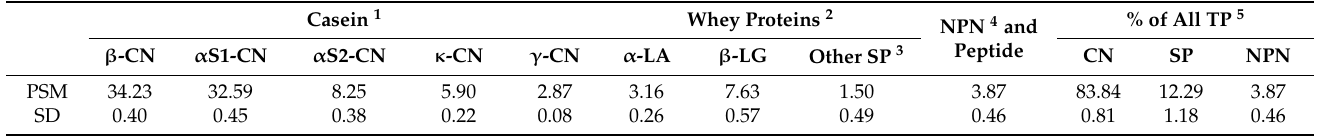
Table 6. Mean ( n = 3) protein fractions observed in capillary gel electrophoresis of pasteurized skim milk used in each replicate during microfiltration and ultrafiltration polymeric spiral-wound